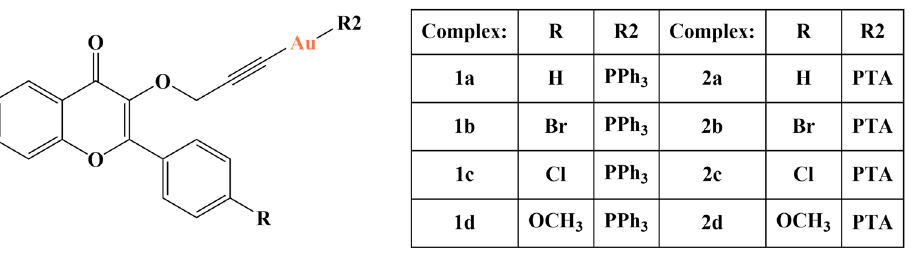
complexes. MTT and SRB assays were both utilized to measure cytotoxicity of all eight gold complexes against MCF-7, HepG5 and Caco-2/TC7 cells. Selectivity was assessed